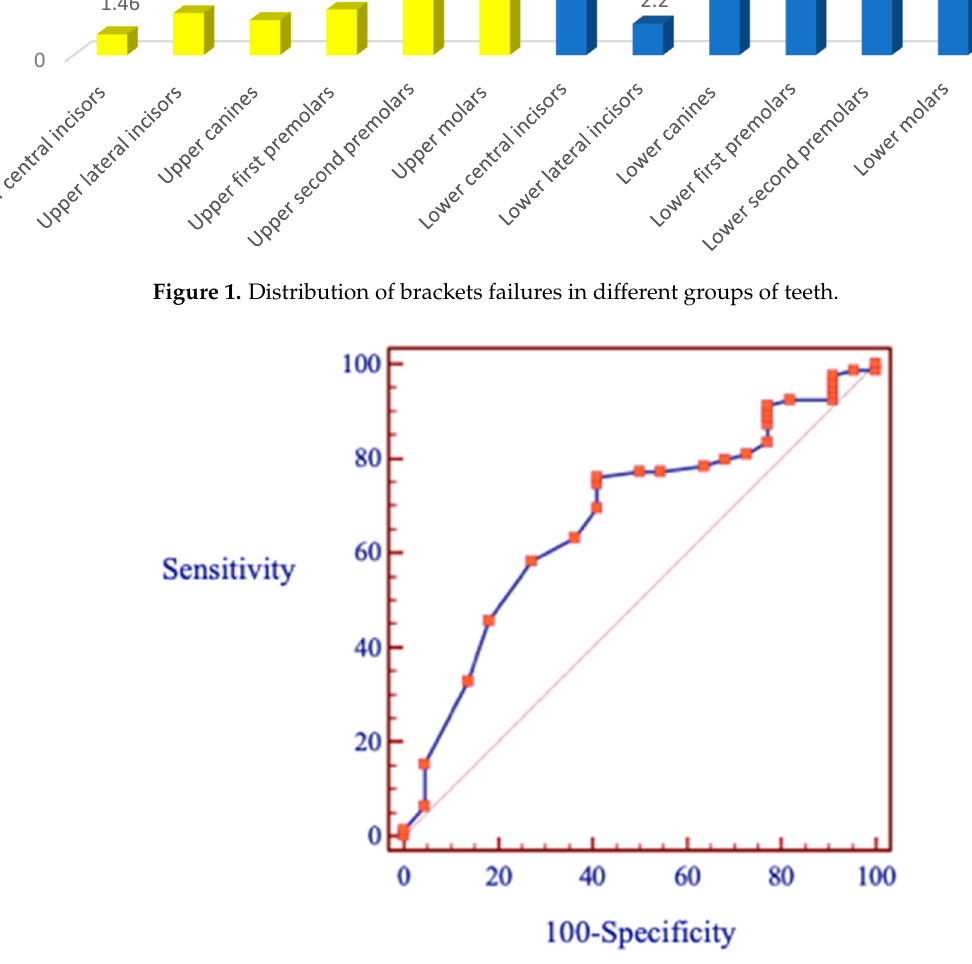
Figure 2. The receiver operating characteristic (ROC) curve to evaluate trade-off between sensitivity and specificity. The area under the curve—67.5%, sensitivity—75.9%, and specificity—59.1%.